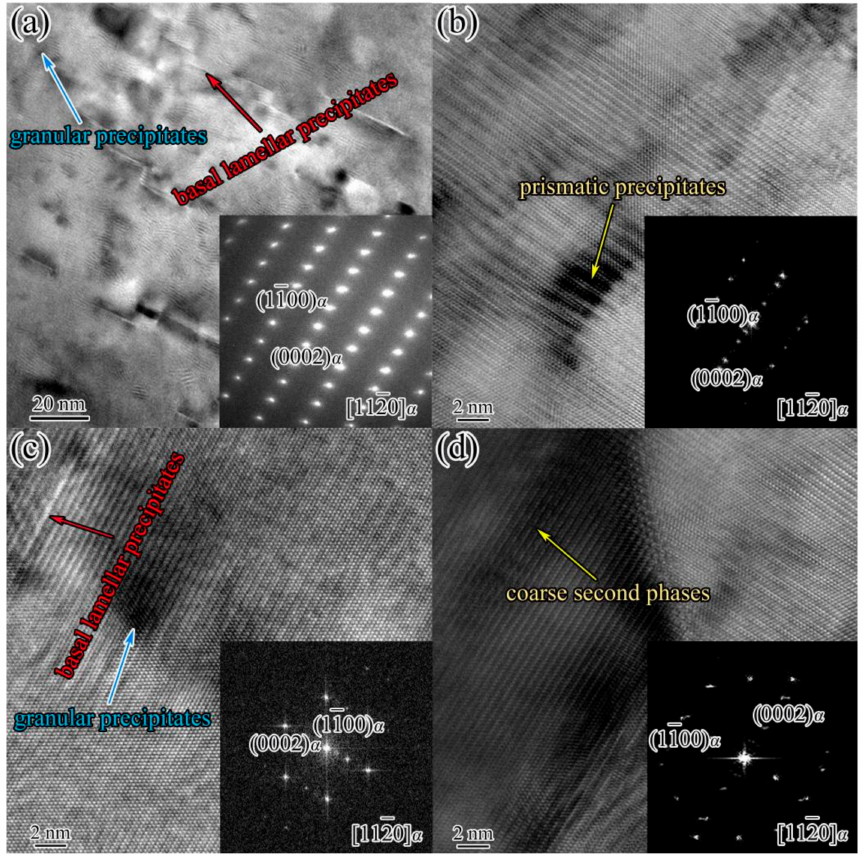
Figure 4. The TEM micrographs and SAED patterns of the IEECAPed and subsequently aged Mg- 2.0Sm-0.4Zn-0.4Zr alloy along [1120] α zone axis. ( a ) TEM micrograph and SAED patterns of the basal lamellar precipitates and granular precipitates; ( b ) HRTEM image of the prismatic lamellar precipitates; ( c ) HRTEM image of the granular precipitates and basal lamellar precipitates; ( d ) HRTEM image of the coarse second